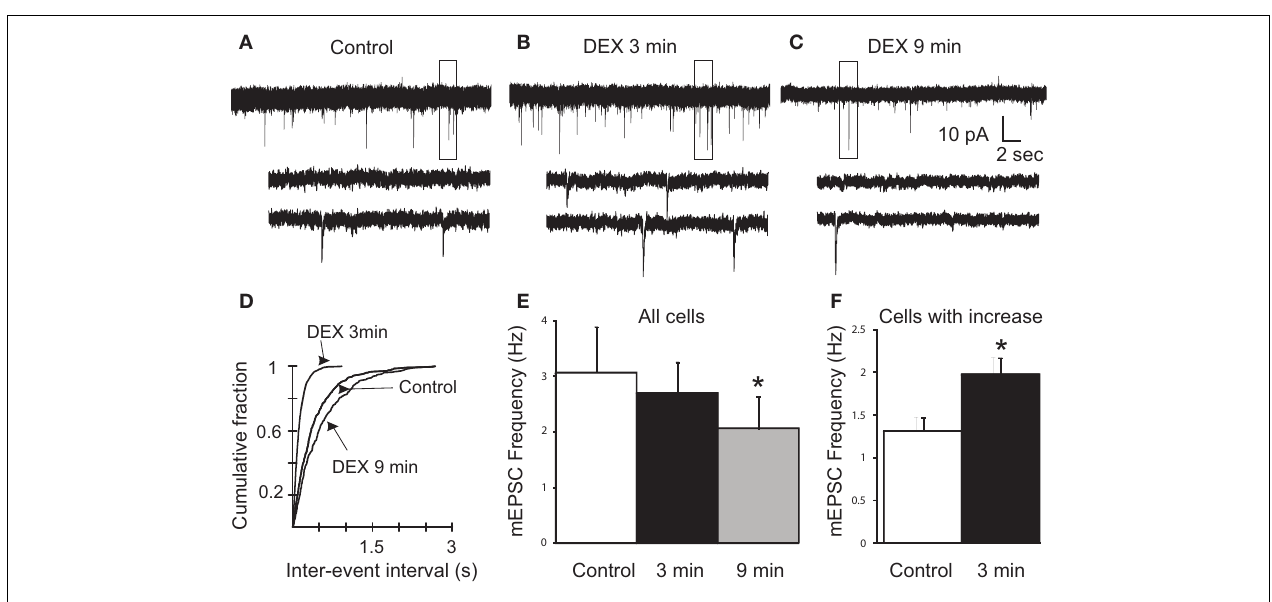
interval distribution from the same cell showed a significant increase at 3min (leftward shift) and a significant decrease at 9min (rightward shift) in mEPSC frequency (K–S test, p < 0.02). (E) Mean group changes in mEPSC frequency caused by 10 µ M DEX at 3 and 9min ( n = 11; ANOVA,Tukey’s; * p < 0.05 from control). (F) Mean group frequency changes in the subset of neurons in which the K–S test detected an increase in mEPSC frequency ( n = 6; * p < 0.05, t -test).